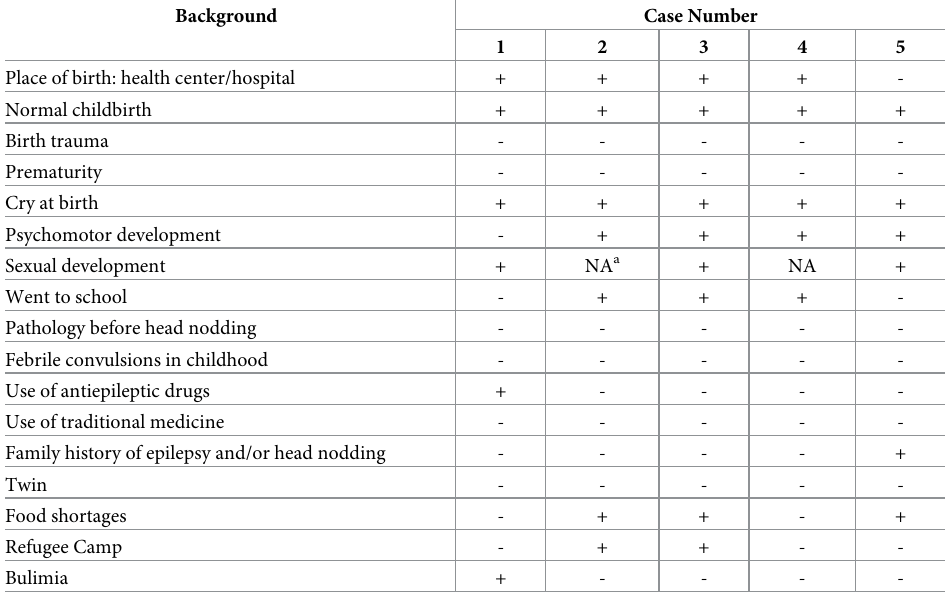
Table 3. History of patients with Nodding Syndrome, Central African Republic,